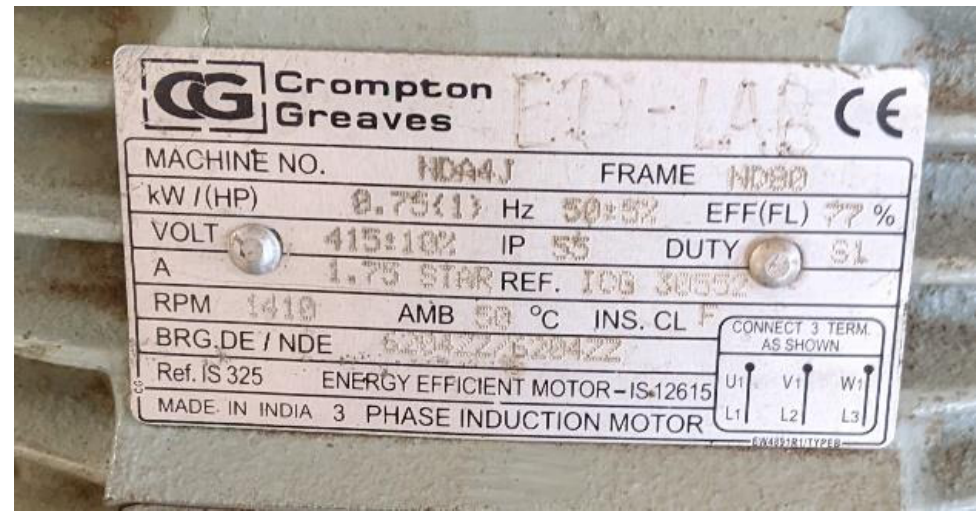
Figure 20. The nameplate of the induction motor used for experimental verification.